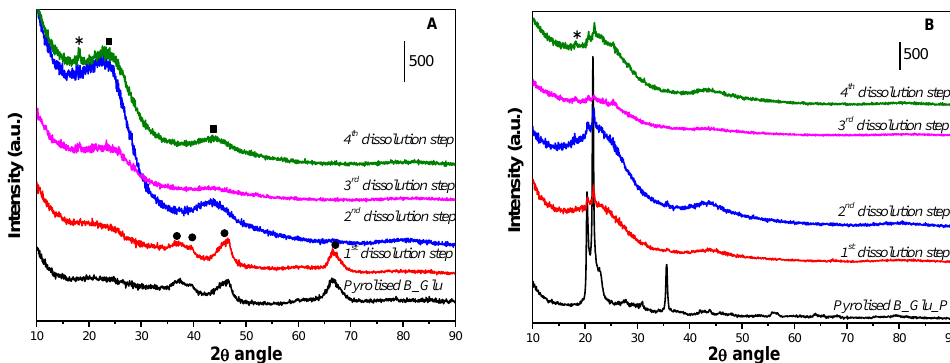
Figure 3. Evolution of X-ray diffractograms of ( A ) pyrolyzed B_Glu sample and ( B ) pyrolyzed B_Glu_P sample after each stage of template dissolution ( ■ carbon, ● γ-alumina, * silicate).